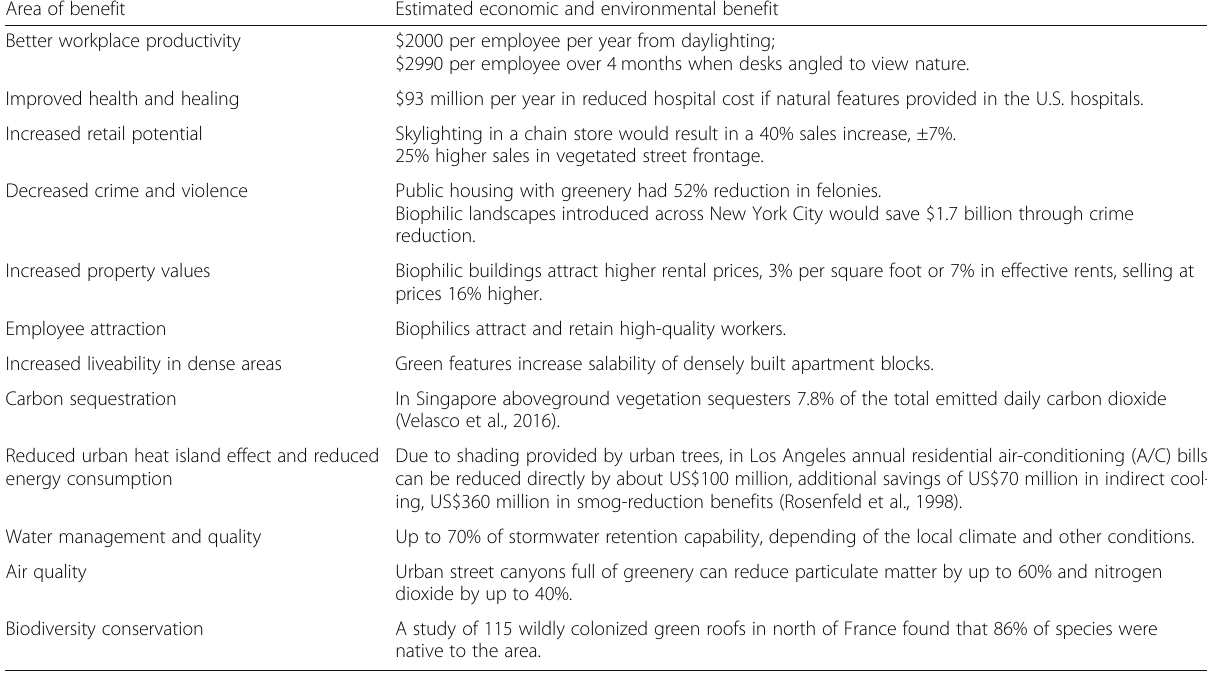
Table 1 Environmental, socio-psychological and economic benefits from biophilic design based on Newman, Beatley and Boyer,